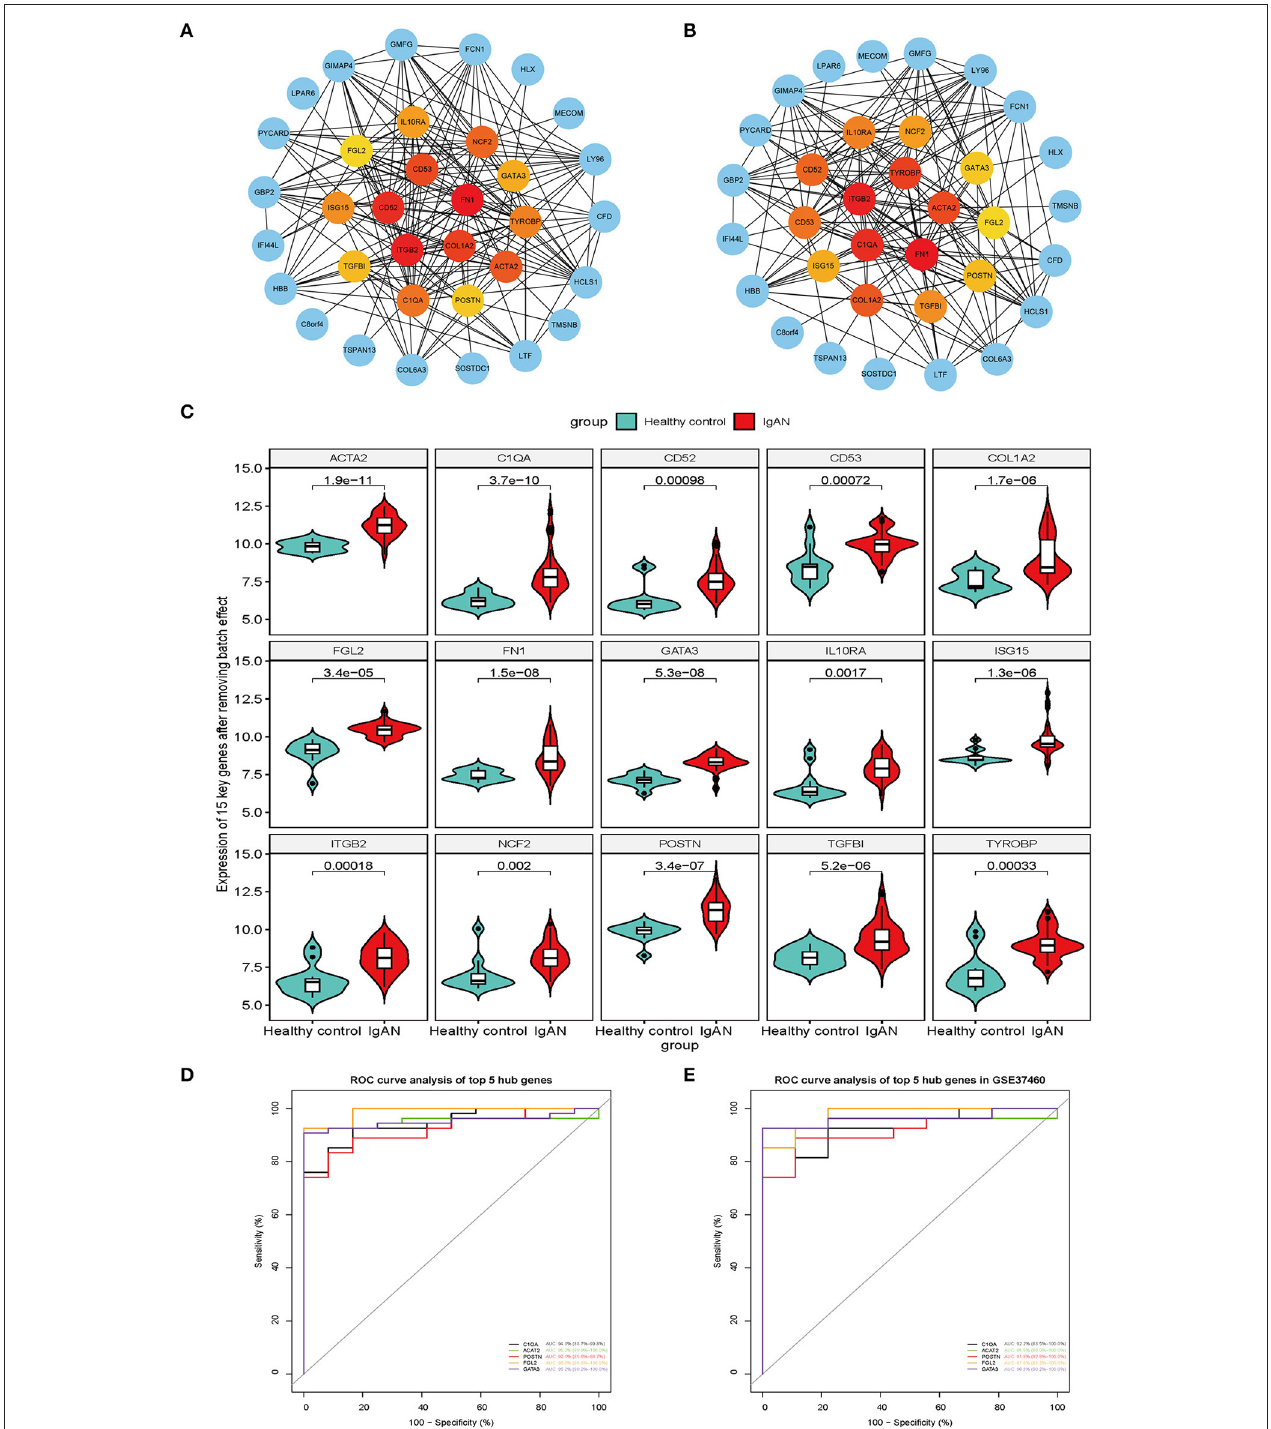
FIGURE 3 | Screen of upregulated overlapping DEGs for key genes. (A,B) Top 15 upregulated overlapping DEGs analyzed with the stress (A) and betweenness (B) algorithms of cytoHubba plugin in Cytoscape, shown in yellow, orange, and red in the middle of the circle. Different colors represent different connectivity with other genes in the PPI network. (C) Violin plot of the gene expression analysis of the 15 key genes after eliminating the batch effect of the original analysis. The 15 genes were more highly expressed in IgAN patients than in healthy control subjects ( P < 0.01). (D) Screen of the top five key genes based on AUC value in the ROC curve analysis. The ROC plot shows AUC (95% CI), sensitivity, and specificity values for POSTN , GATA3 , C1QA , ACAT2 , and FGL2 . (E) Verification of the five hub genes ( POSTN , GATA3 , C1QA , ACAT2 , and FGL2 ) in GSE37460 by ROC curve analysis, with AUC (95% CI), sensitivity, and specificity values.